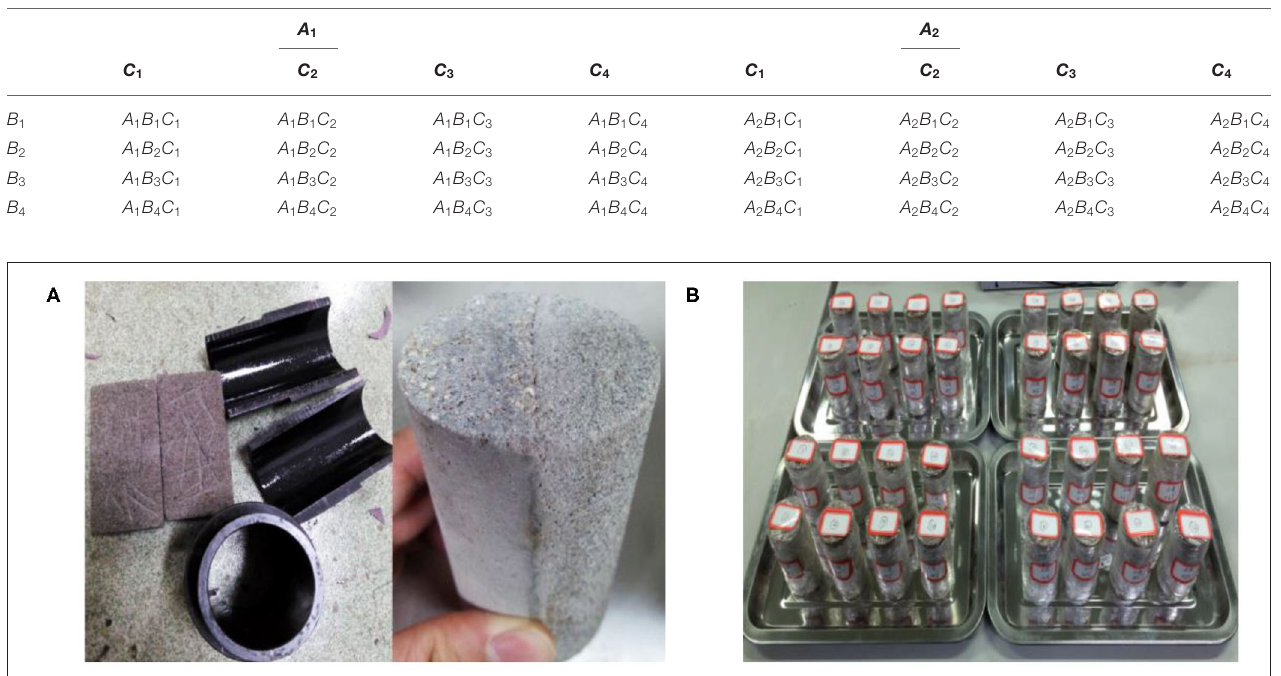
TABLE 2 | 2 × 4 × 4 factorial experimental design model.